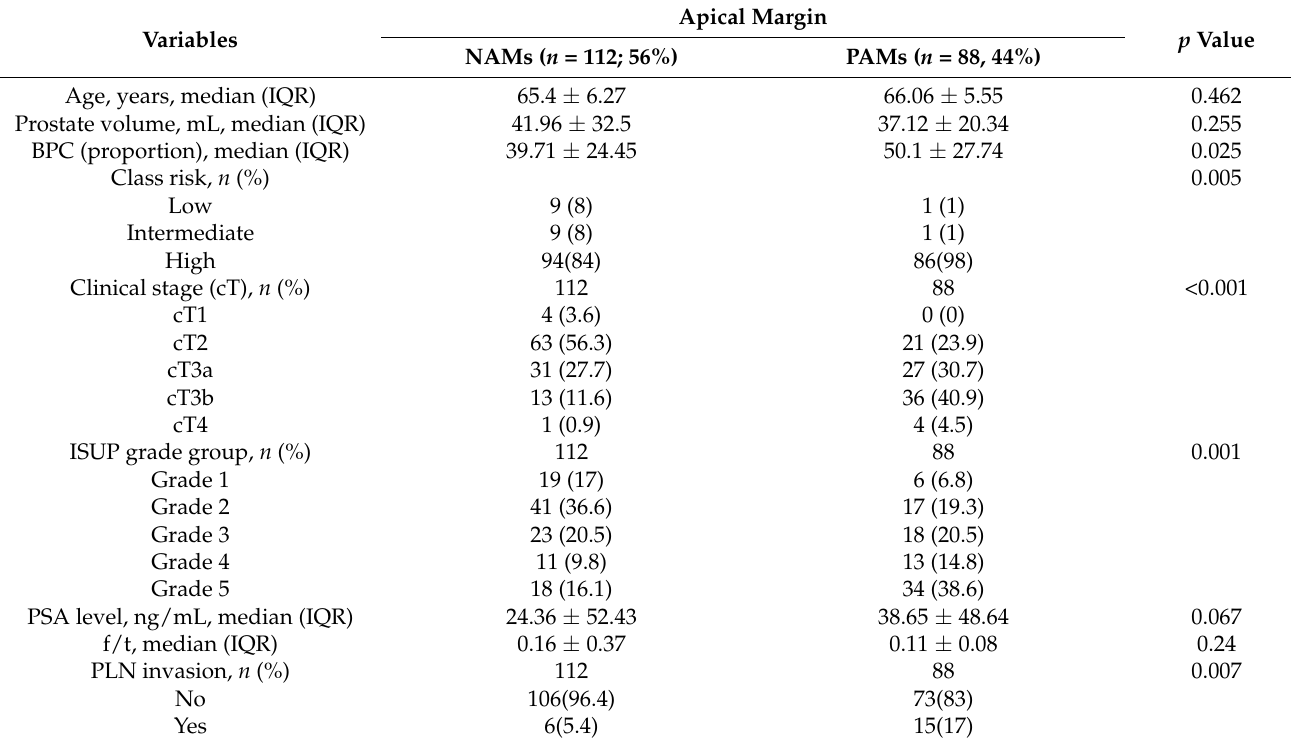
Table 3. Distribution of clinical and pathological factors in the subgroups of patients according to apical margins status.